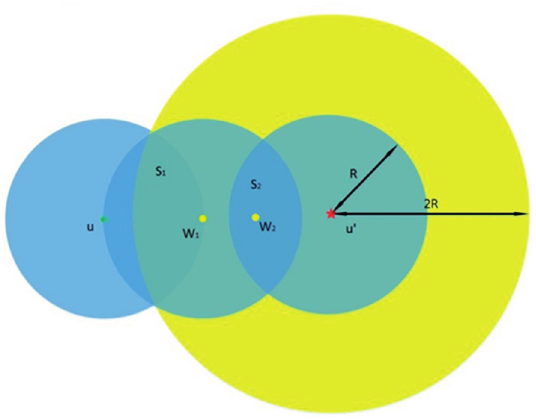
Figure 4. An example to illustrate that using the LD-2 detection model fights against a replication attack.